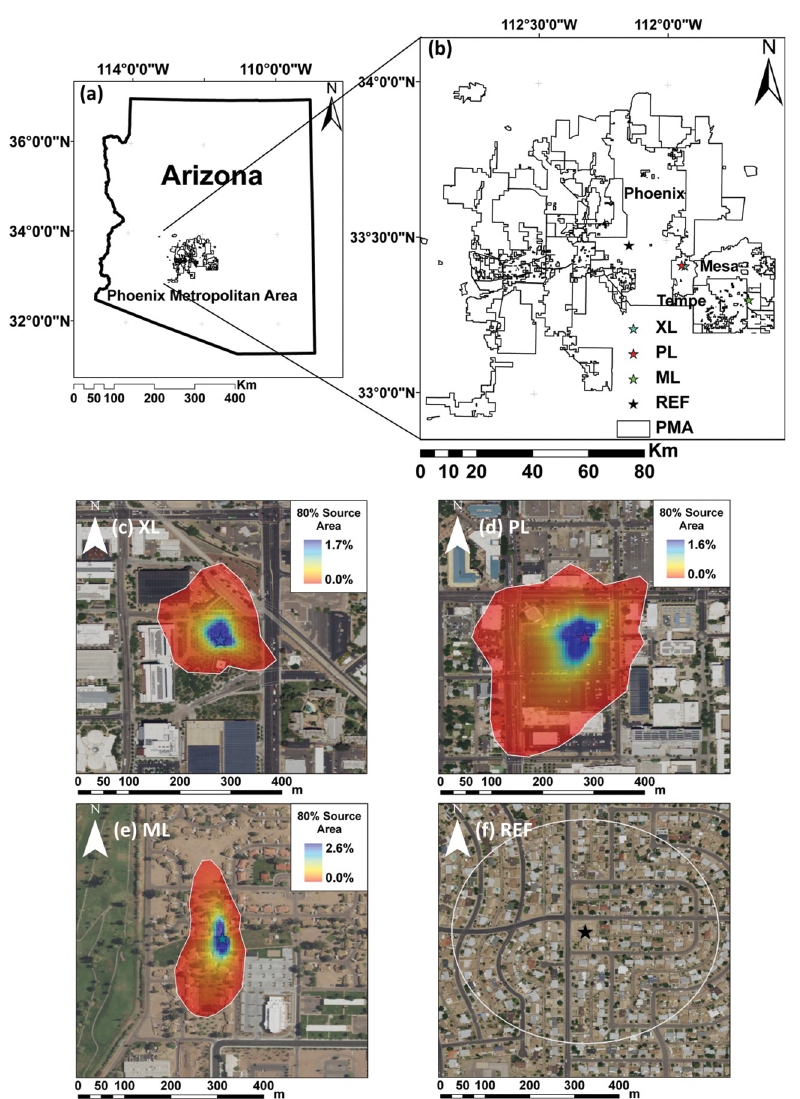
Fig 1. Location of the study sites. (a) Location of the Phoenix Metropolitan Area, and (b) the four study sites: (c) xeric landscaping (XL) site at ASU Tempe campus; (d) parking lot (PL) site near a high traffic intersection at ASU Tempe campus; (e) mesic landscaping (ML) site near residential housing at ASU Polytechnic campus; and (f) suburban (REF) site in Phoenix. Contour polygon and color gradient represent the 80% cumulative source area for each site. Aerial images of the sites correspond to National Agricultural Imagery Program (NAIP) from the U.S. Geological Survey (https://doi.org/10.5066/F7QN651G).